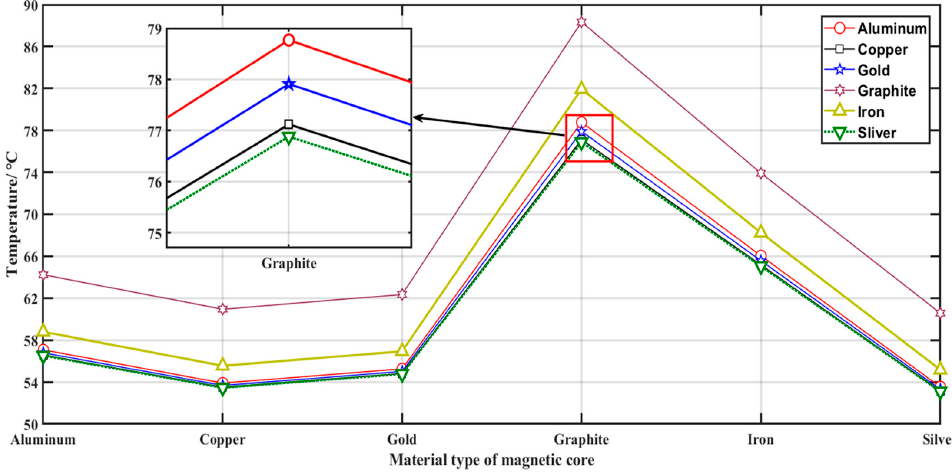
Figure 11. Temperature profiles for different core materials.